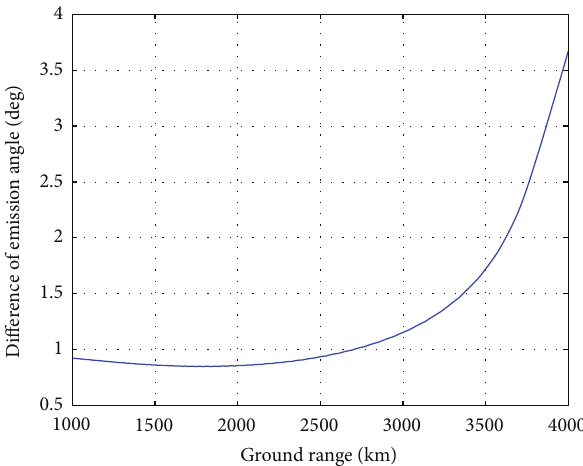
Figure 17: The curve of the difference 𝛼